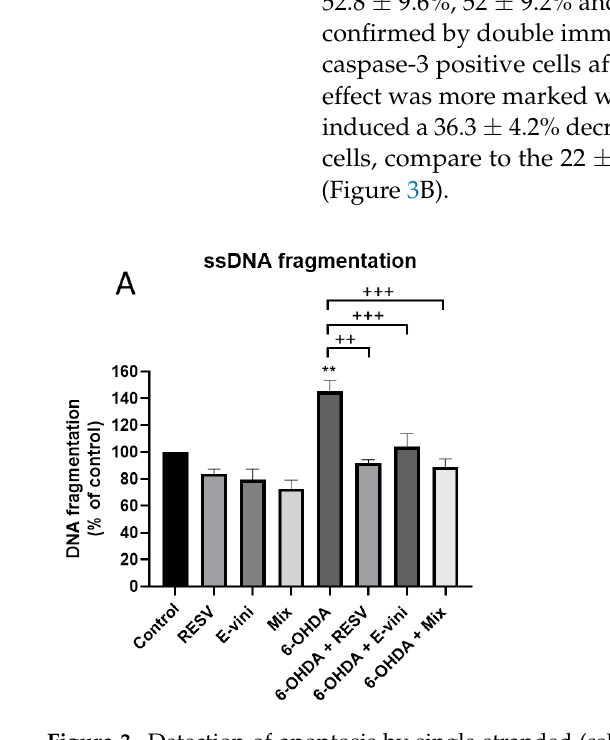
Figure 3. Detection of apoptosis by single stranded (ssDNA) fragmentation ( A ) and by caspase-3 and TUNEL double immunofluorescence ( B ). PC12 neurons pre-treated for three hours with culture medium (control), resveratrol, viniferin or a mixture of both polyphenols (Mix) all at a final concentration of 10–9 M. Cells were then treated with 6-OHDA at 50 μM for 24 h, as described in the Material and Methods. Apoptotic neuronal cells among 300 randomly chosen neuronal cells were counted on 10 different optical fields from 3 slides per group, as described in Material and Methods. Data are expressed as means ± SEM of three experiments. For each experiment, each condition was assessed in triplicate. Asterisks (*) indicate statistical differences between the treatments and their respective controls (*** p < 0.001, ** p < 0.01), plus signs (+) denote statistical differences between 6-OHDA and 6-OHDA in the presence of polyphenols (+++ p < 0.001, ++ p < 0.01), dollar sign ($) indicates statistical difference between 6-OHDA+resveratrol and 6-OHDA+mixture of the two polyphenols ($$$ < 0.001) and number sign (#) indicates statistical difference between 6-OHDA+viniferin and 6-OHDA + mixture of the two polyphenols (### p < 0.001).